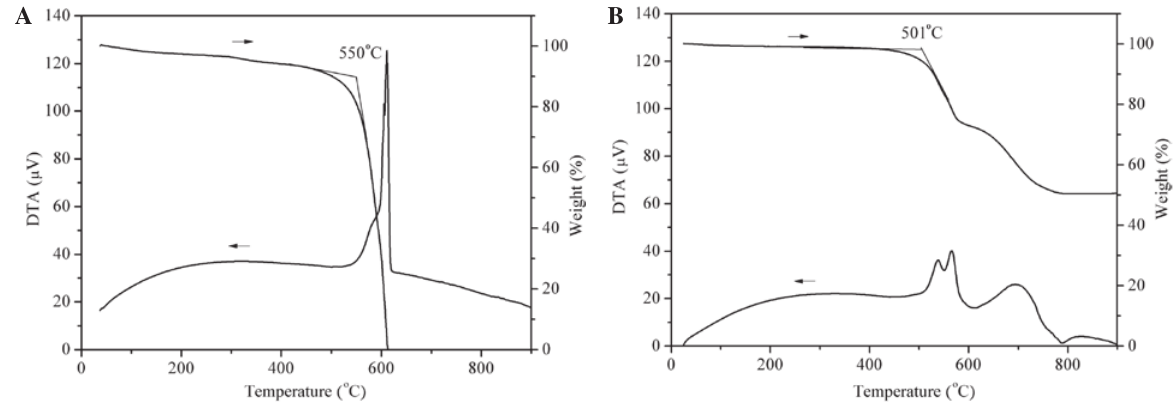
Figure 4: TGA/DTA curves of (A) PI and (B) PG composite.